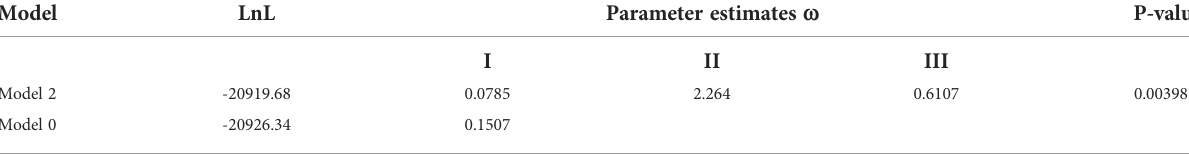
TABLE 2 Branch model tests for positive selection in monocots ’ FT genes. Model